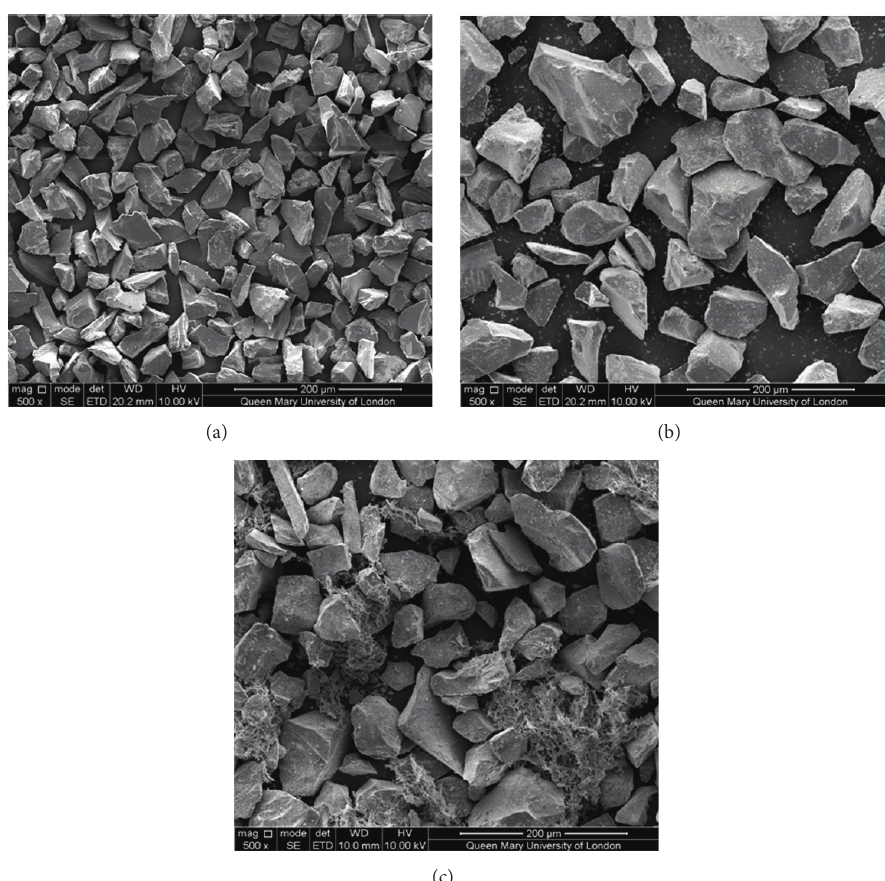
Figure 1: Scanning electron microscopy images of (a) alumina, adapted from Farooq et al. 2013 [24], (b) Na0SR, and (c) 45S5.